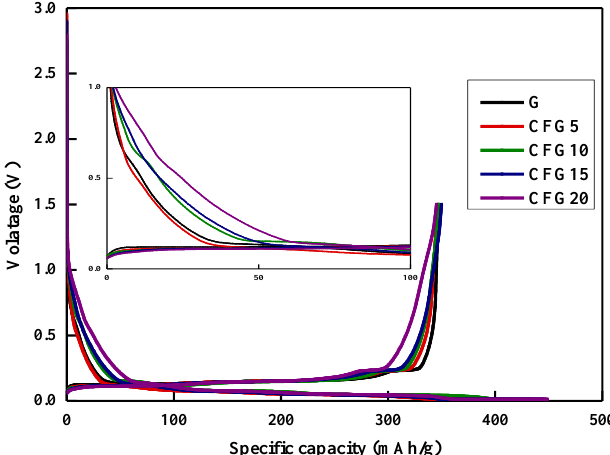
Figure 2. Galvanostatic charge/discharge (GDC) at 1st cycle.